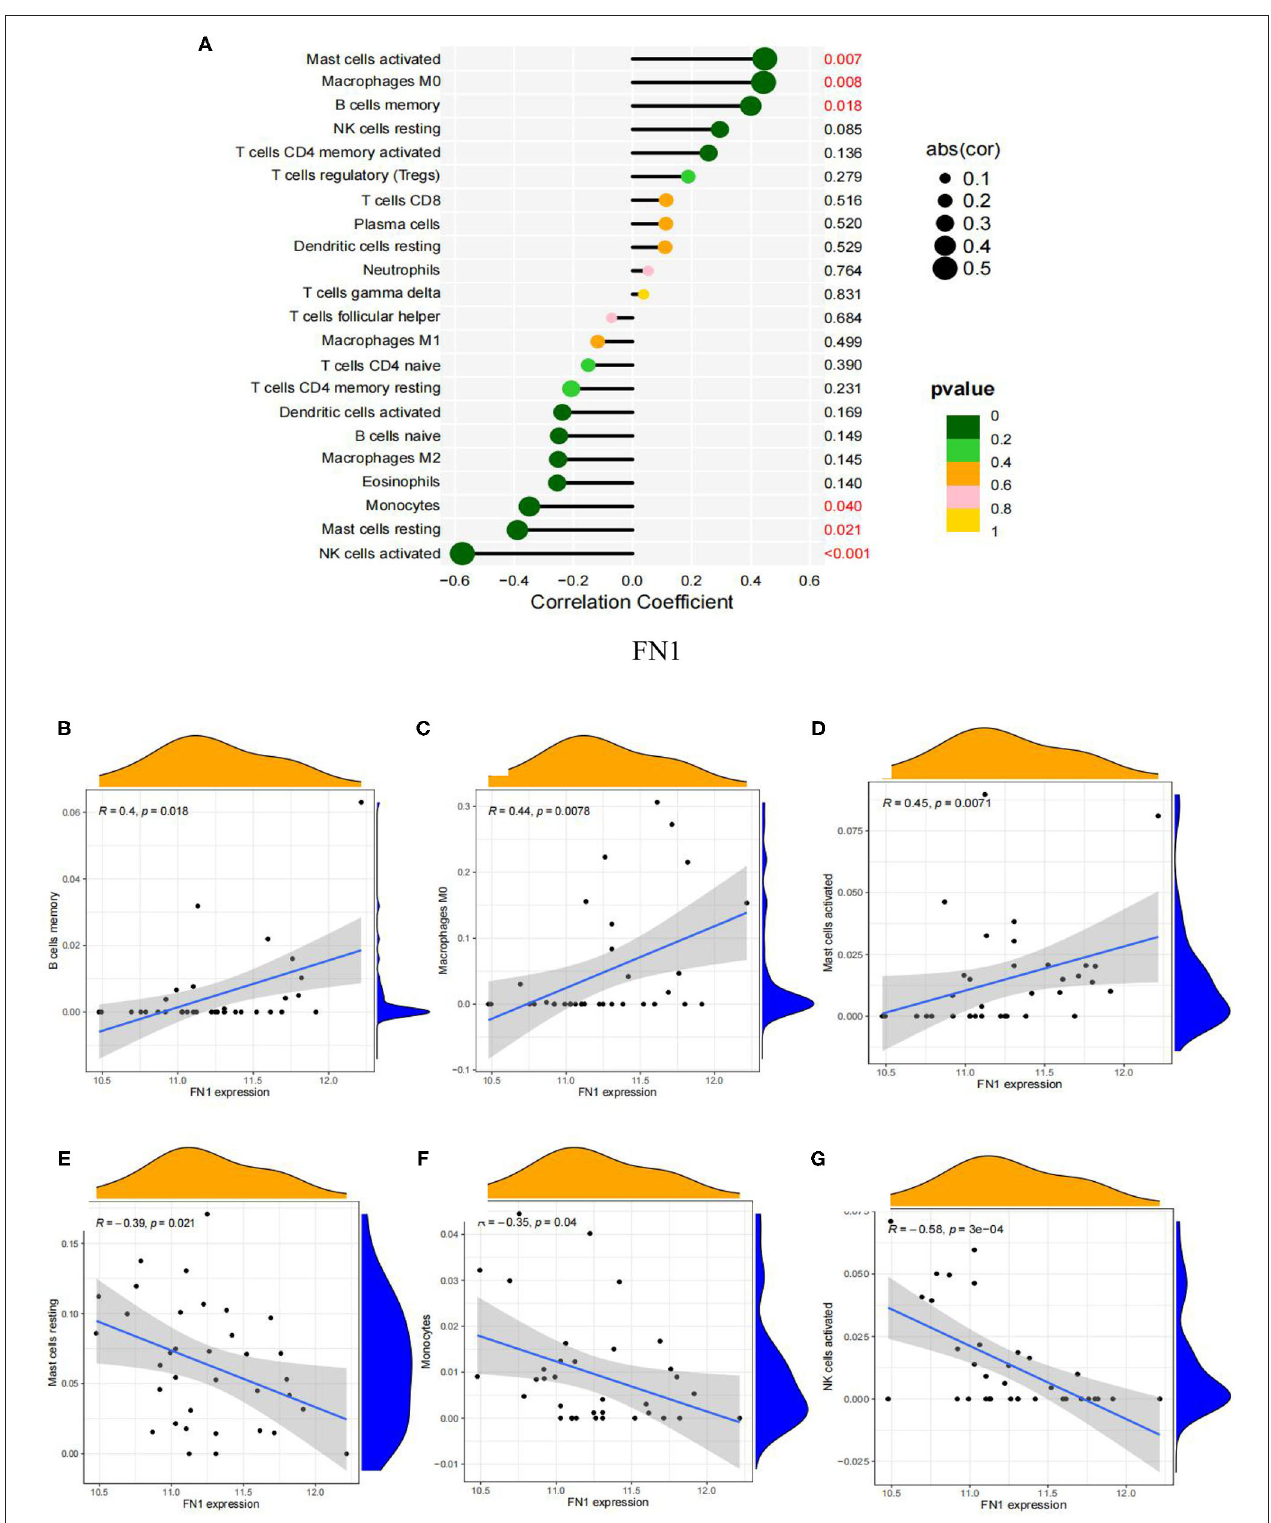
FIGURE 10 | Visualization of the results of immune cell infiltration and FN1 correlation analysis based on the combined data matrix of GSE12644 and GSE51472. (A) Correlation between FN1 and infiltrating immune cells. The size of the dots represents the strength of the correlation between genes and immune cells; the larger the dots, the stronger the correlation, and the smaller the dots, the weaker the correlation. The color of the dots represents the p -value, the greener the color, the lower